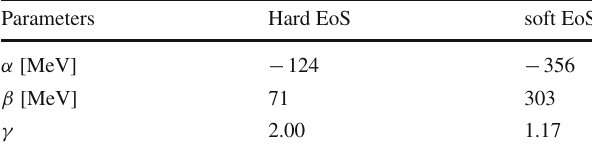
Table 2 Parameters used in the hard and soft Skyrme potential [58] Parameters Hard